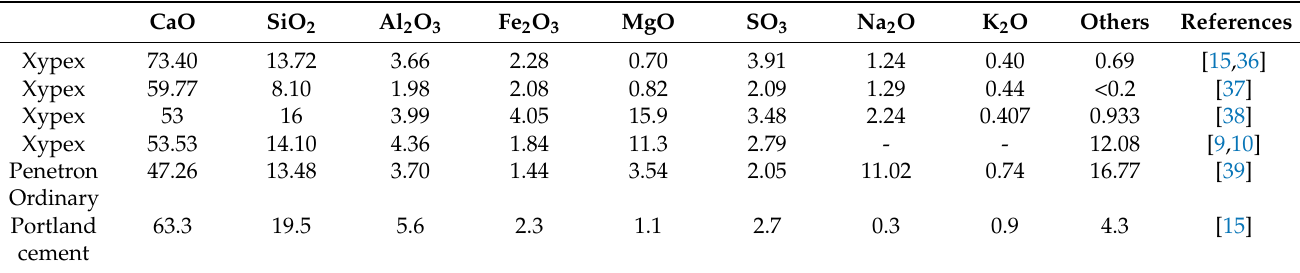
Table 2. Chemical composition of crystalline materials from XRF